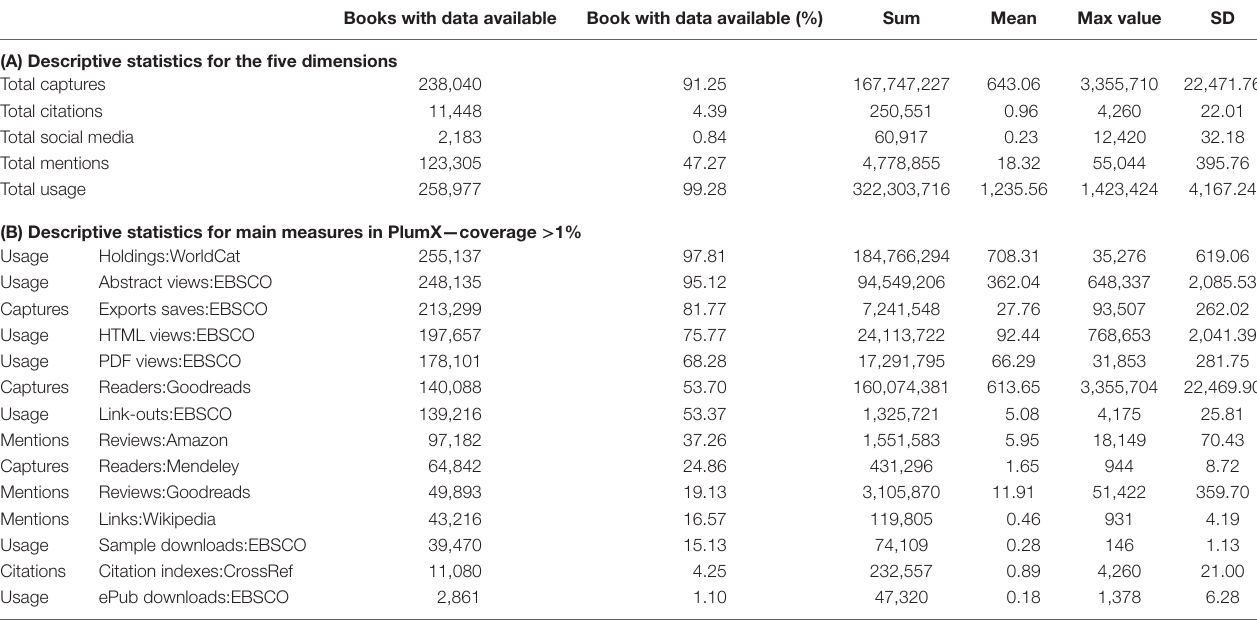
TaBle 3 | Statistical overview for the dimensions and main measures retrieved via PlumX according to the ISBN of the print version of the book. Books with data available